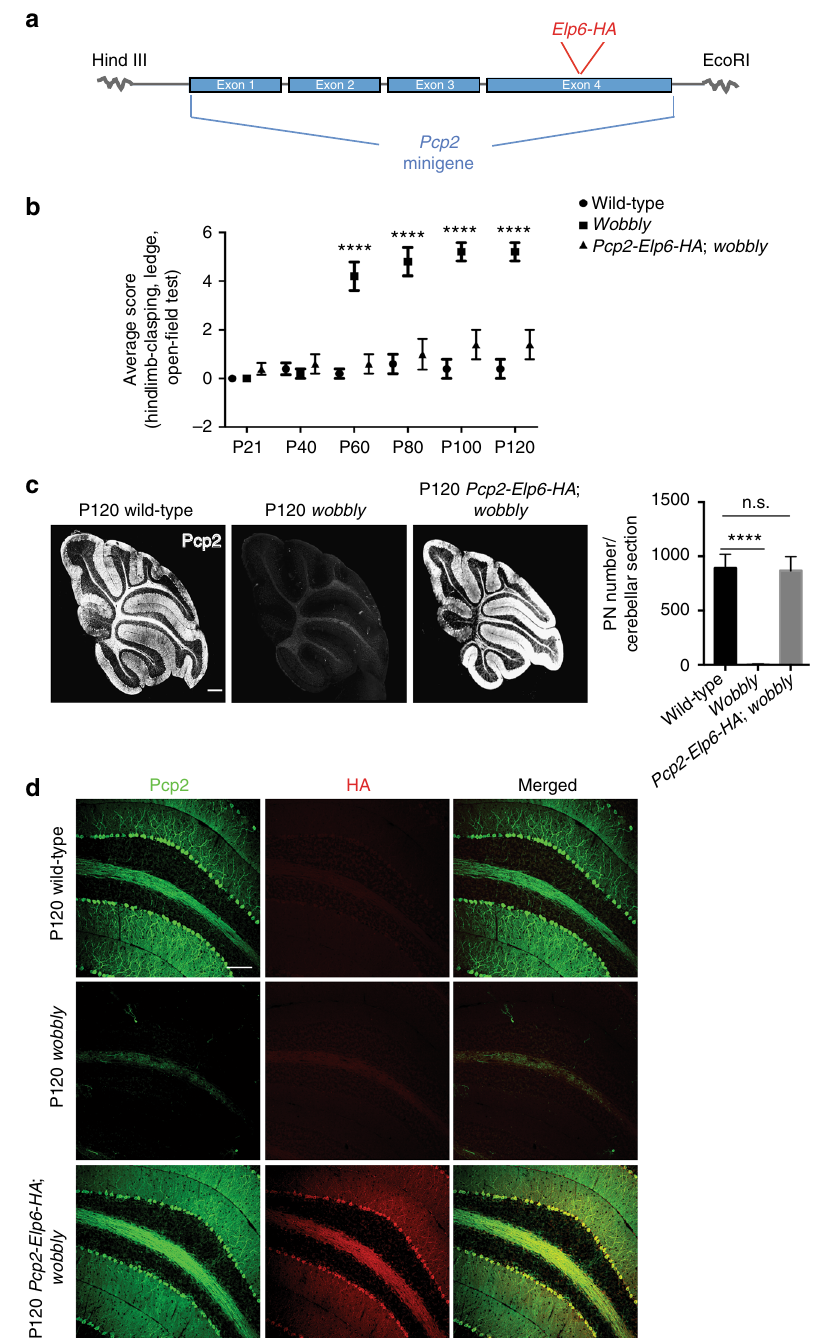
Fig. 3 Transgenic complementation of the Elp6 defect. a Generation of the Pcp2-Elp6-HA transgenic construct. b Ataxic phenotype scoring of wobbly and Pcp2-Elp6-HA ; wobbly mice relative to wild-type ( n = 6 (3 males and 3 females) for each of the genotypes). c PN immuno-staining and quanti fi cation in transgenic ( Pcp2-Elp6-HA ; wobbly ) mice relative to wild-type controls at P120. d Immuno fl uorescent staining of P120 wild-type, wobbly and transgenic sagittal sections with anti: Pcp2 or HA antibody. For ( c ) and ( d ) n = 5 for each of the genotypes; representative images are shown. Scale bars: ( c ) 500 μ m; ( d ) 100 μ m. Statistical evaluation: two-way ANOVA and Sidak ’ s multiple comparisons test. Statistically signi fi cant differences are indicated ( **** P ≤ 0.0001). Data represent mean ±